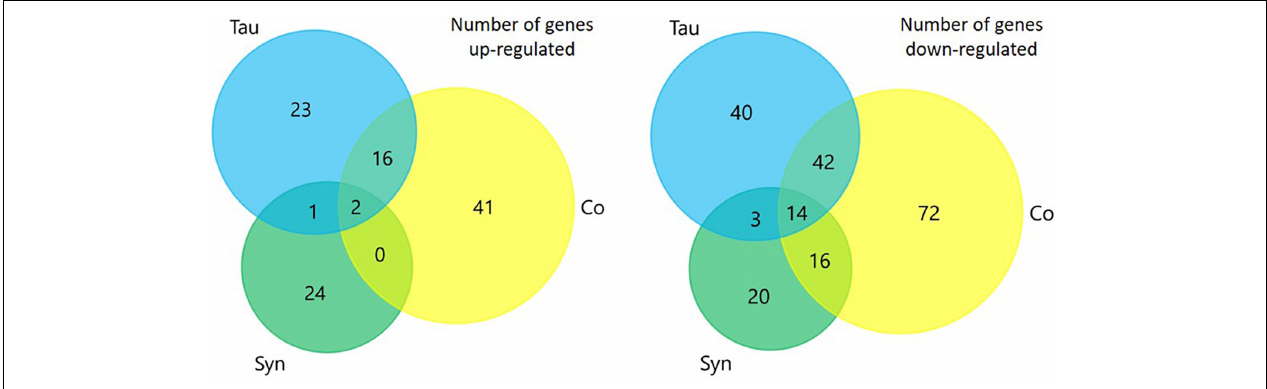
FIGURE 8 | Venn diagrams representing the number of proteins that were differentially expressed in each strain when compared to AX2. There were more proteins down-regulated in each of the sets of strains compared to the number that were up-regulated. The coexpression of tau and α -synuclein lead to the expression of more proteins being up- or down-regulated than either did